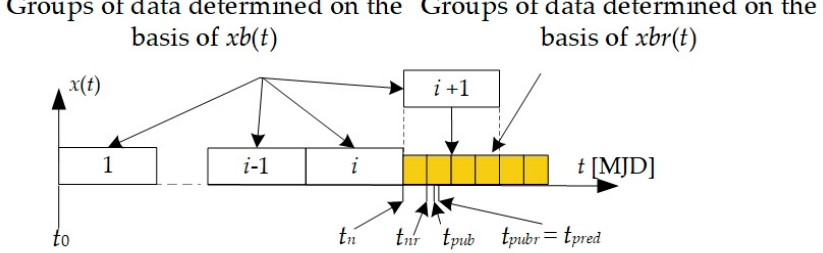
Figure 8. A method of constructing a time series based on the xb ( t ) and xbr ( t ) values published by BIPM.